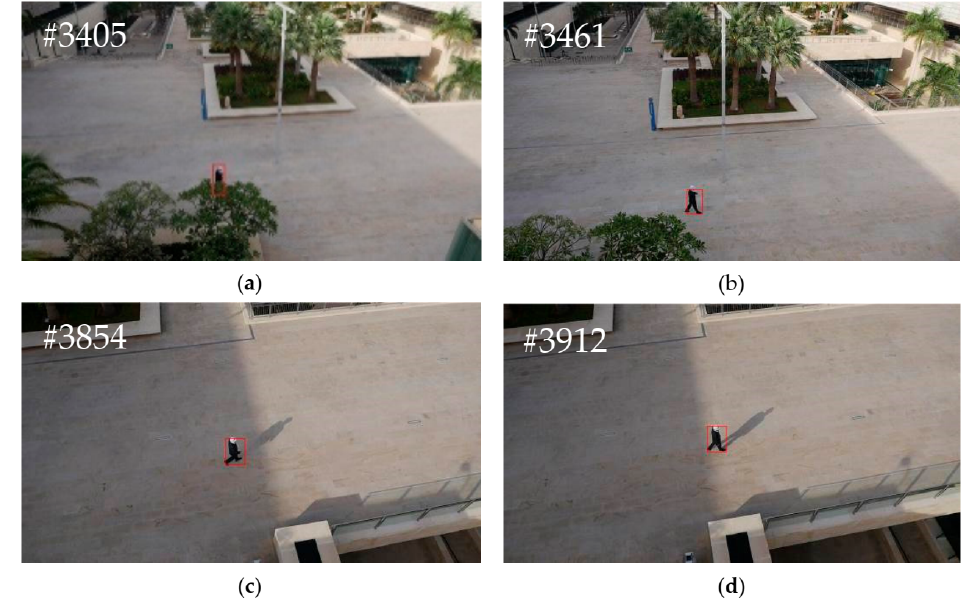
Figure 15. UAV123 datasets tracking test of person19. ( a ) Object obstructed; ( b ) object appear after being obstructed; ( c ) object in a location with low illumination; ( d ) object at the intersection of areas with different illumination